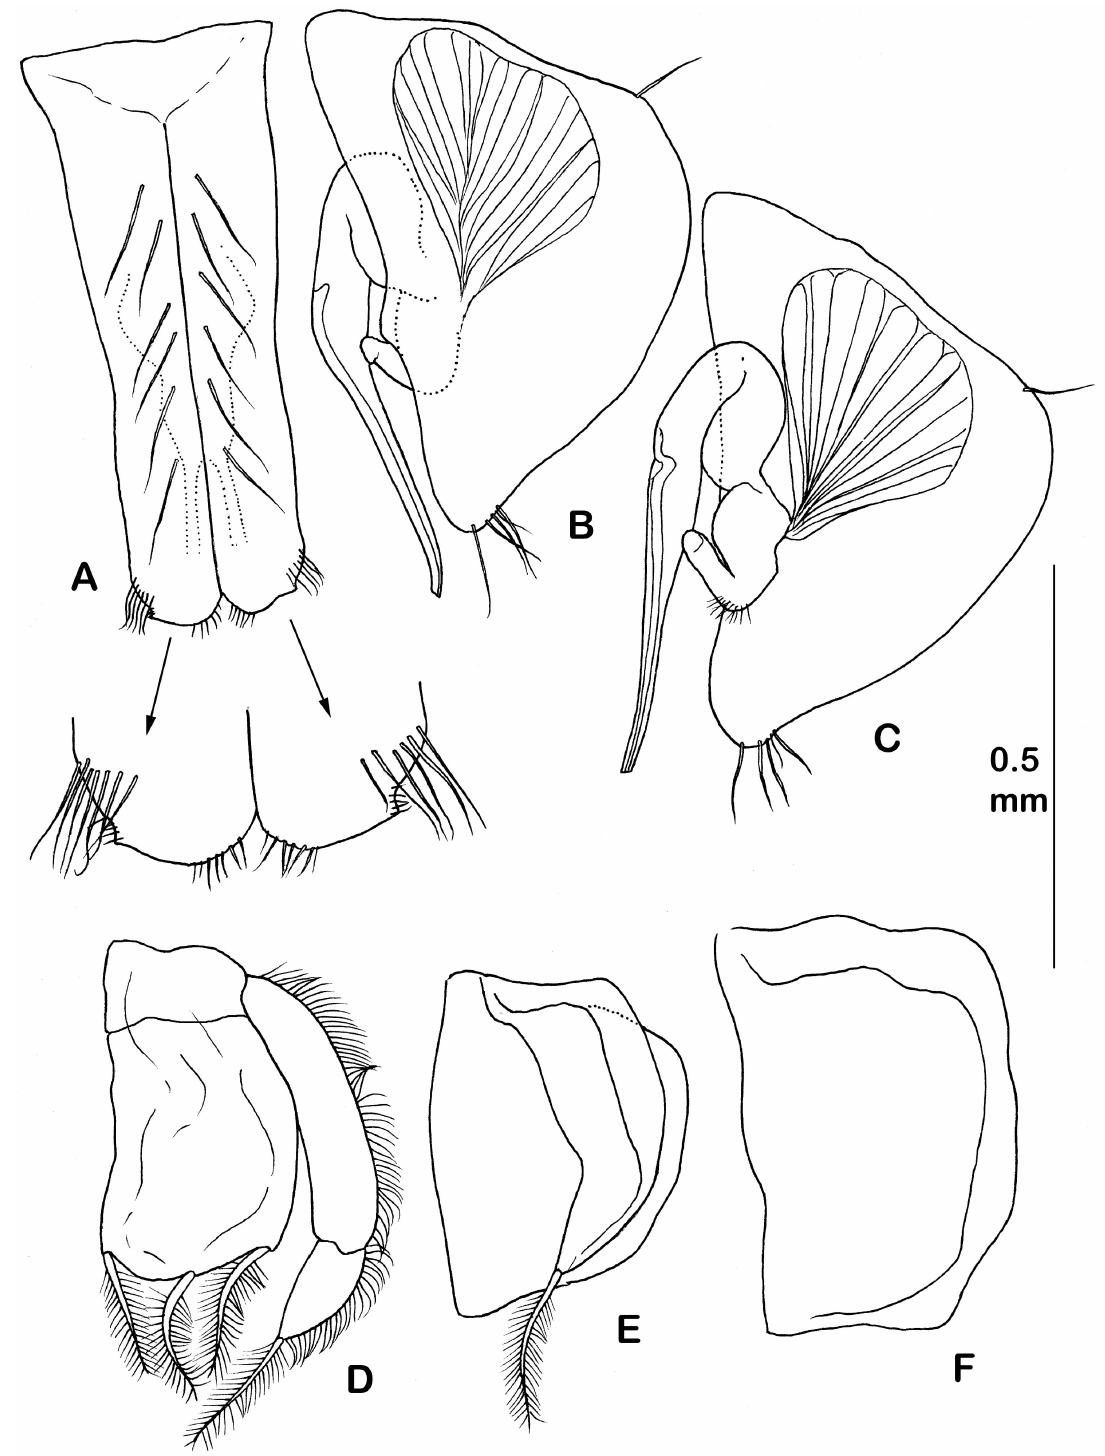
Figure 8. Eurycope producta GO Sars, 1868. Male (ZMH K-45592): ( A ) pleopod I (distal margin enlarged); ( B ) left pleopod II, ventral view; ( C ) right pleopod II, dorsal view; ( D ) pleopod III; ( E ) pleopod IV; ( F ) pleopod